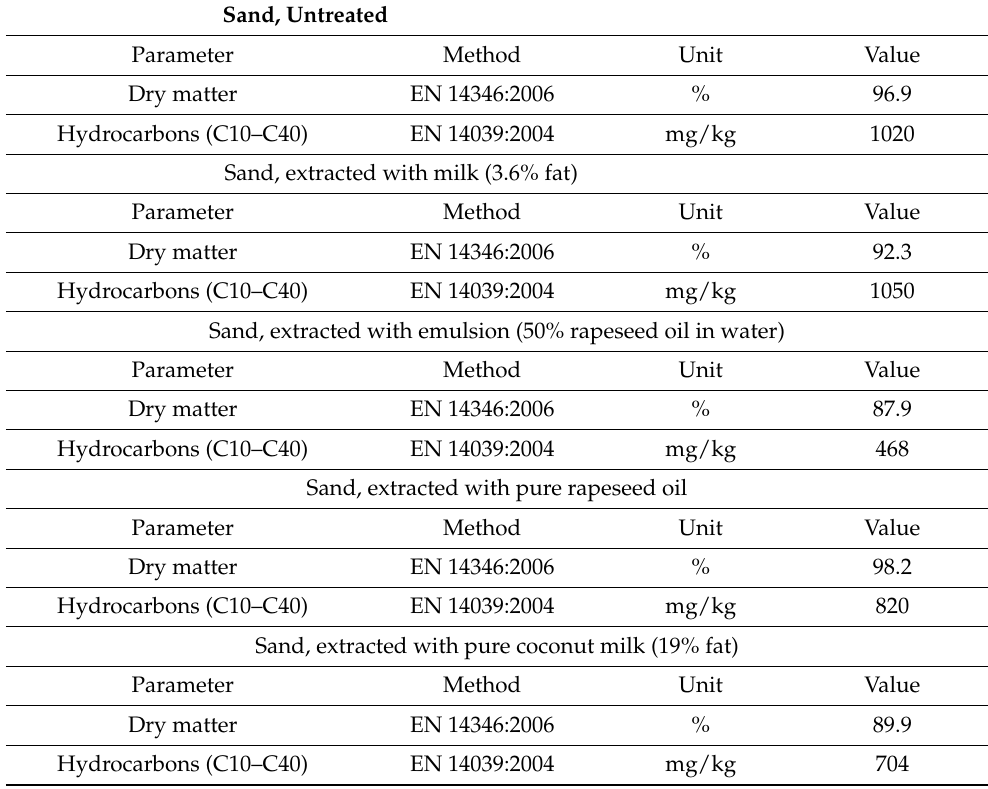
Table 3. Extraction experiments with sand from Droesing.